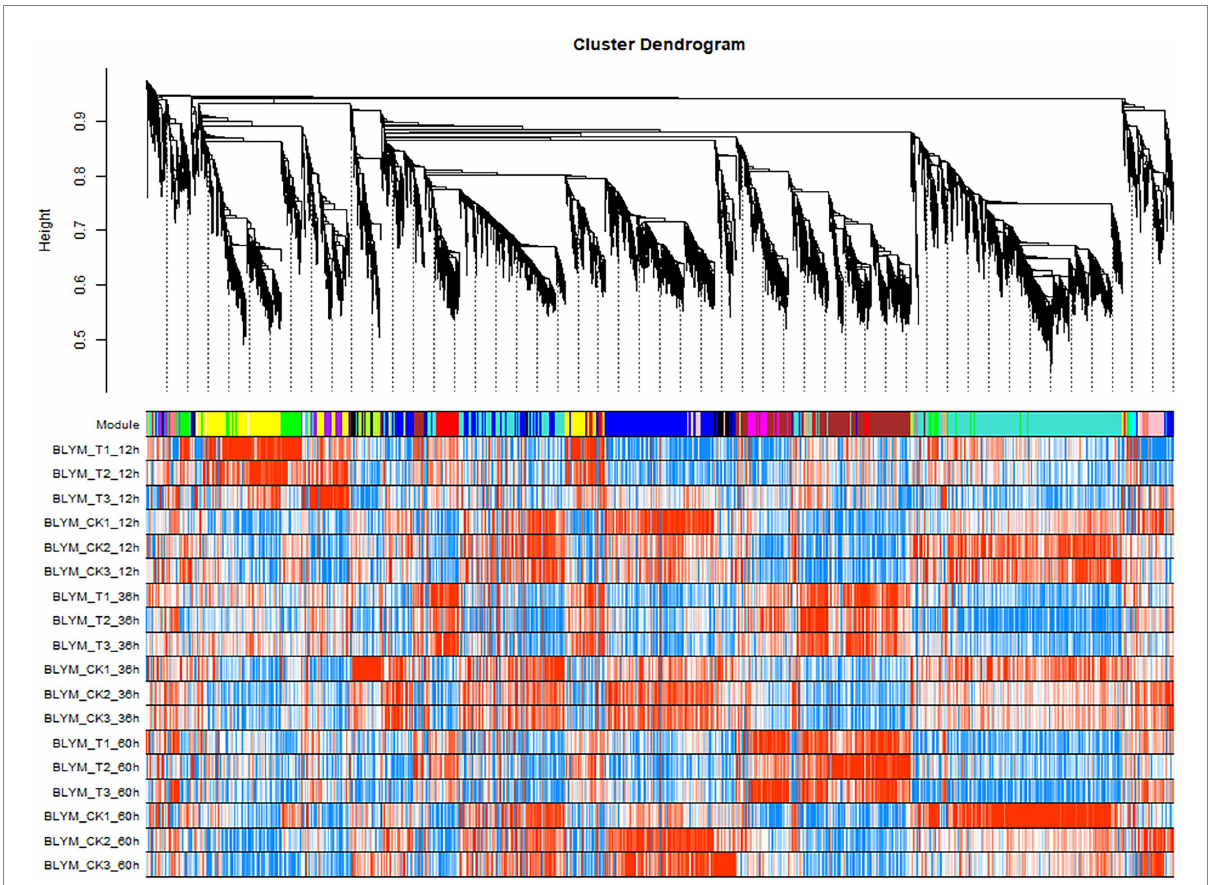
FIGURE 2 Helictotrichon virescens transcript clustering and module identification. The different colors represent different modules, whereby the grey module denotes a collection of differential genes not assigned to other modules. The turquoise module gathered the most genes (2,714 differential genes), while orange, dark-orange, dark-grey, and dark-turquoise modules gathered the least genes (13 genes), among which each module gathered 366 genes on average.